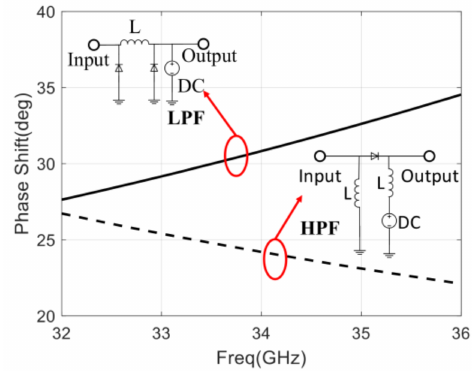
Figure 10. Phase shift range of high-pass and low-pass phase-shifting unit with control voltage varying from 0 to 1